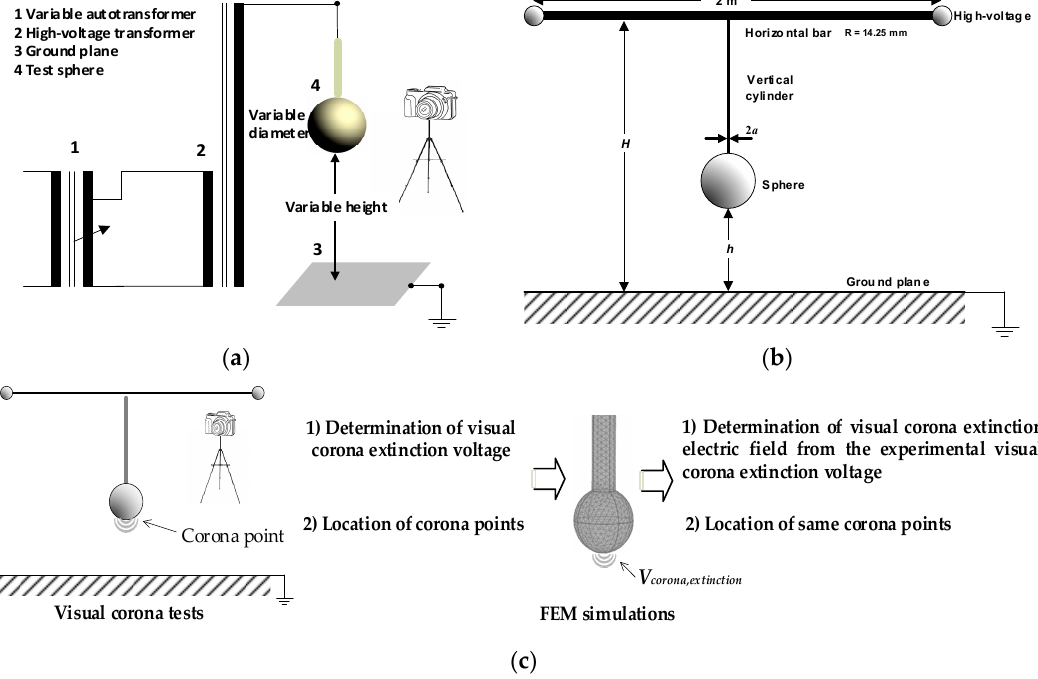
Figure 2. ( a ) Experimental setup for ac tests. A similar setup was used for the direct current (dc) tests; ( b ) Sketch of the spherical electrode configuration; ( c ) Diagram of the proposed approach to determine the visual corona extinction electric field. FEM: Finite element method.